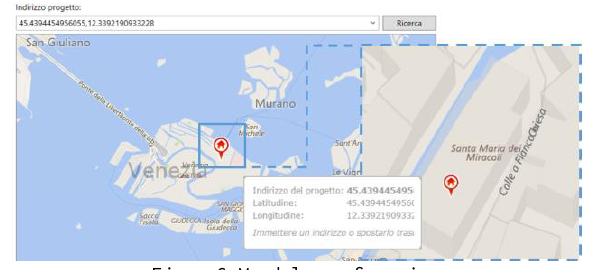
Figure 6. Model georeferencing.